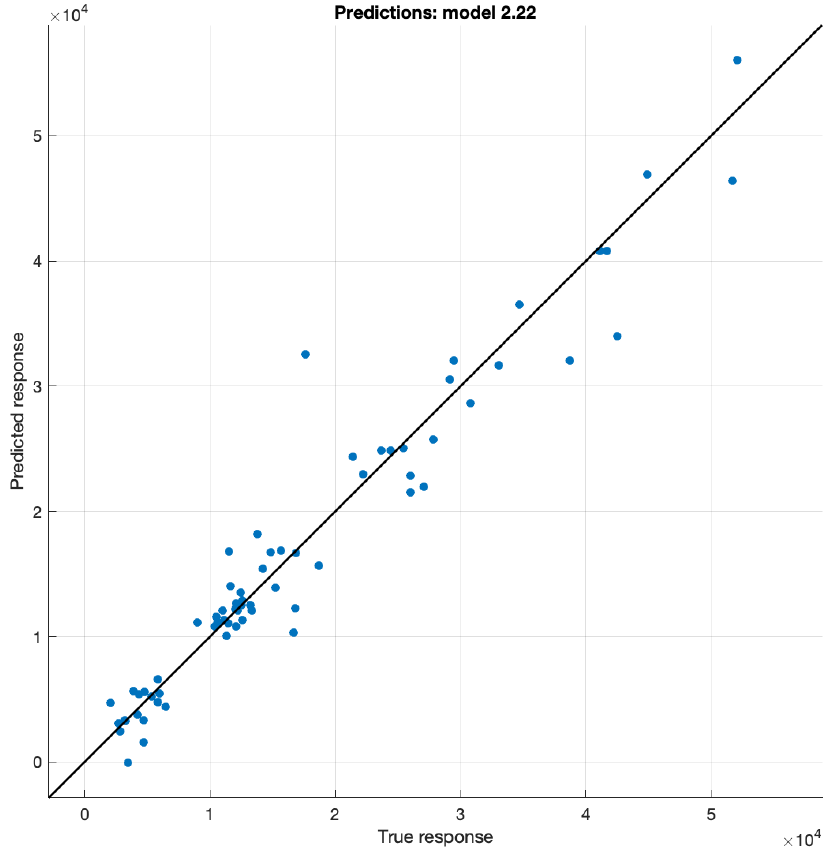
Figure 5. Predicted vs. actual annual mean salary across occupations groups using